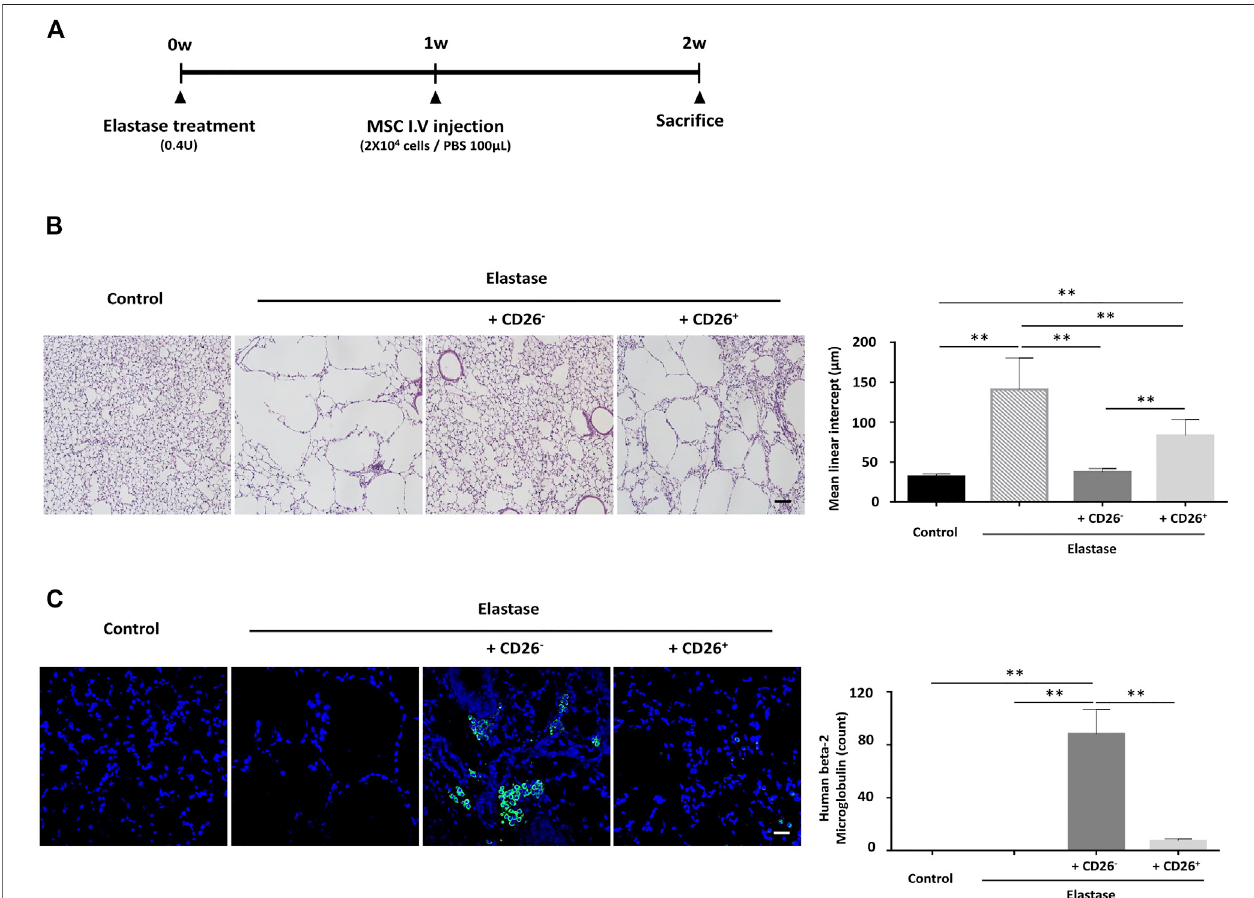
FIGURE5| hUCB-MSCswithlowCD26expressiondemonstrateenhancedtherapeuticeffectsinamouseemphysemamodel. (A) Timeschedulefortheelastase- induced emphysema mouse model used in the experiment. (B) Representative images of H&E-stained lung tissue showing alveolar wall destruction by elastase (left) . Bar graph of mean linear intercept from images of H&E staining (right) ( n (cid:1) 12); Scale bar, 50 μ m. (C) Representative images of mouse lung tissue immunostained with human beta-2 microglobulin (green). Nuclear DNA was counterstained with Hoechst 33342 (blue) (left) . Bar graph of human beta-2 microglobulin-positive cell counts (right) ( n (cid:1) 3); Scale bar, 50 μ m. Abbreviation: H&E, Hematoxylin and Eosin. * p < 0.05; ** p < 0.01.